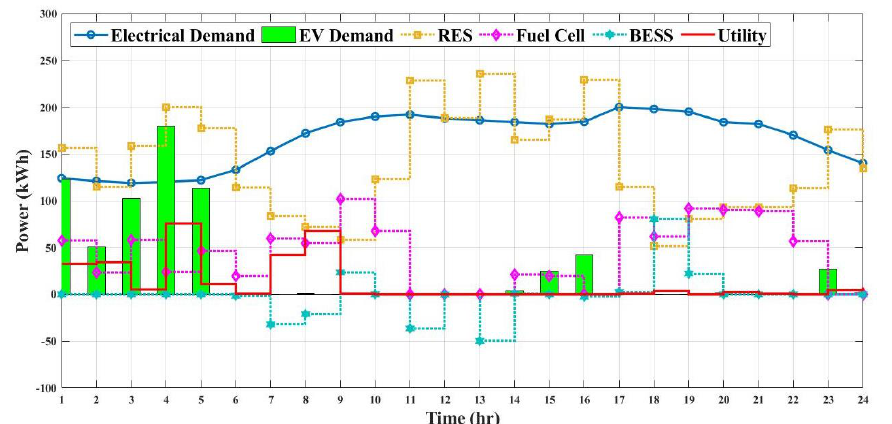
Figure 18. Electrical powers for Case